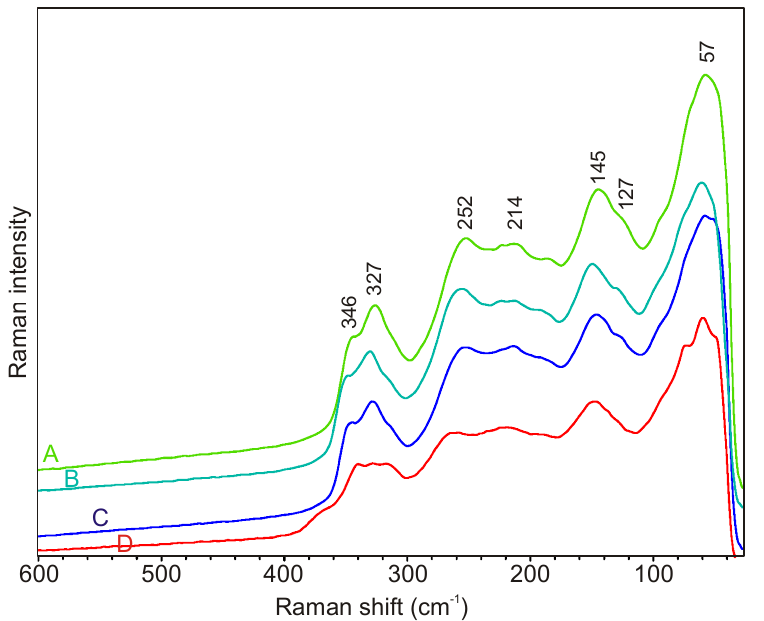
Figure 15. Comparison of Raman spectra of chovanite from Kľačianka (two samples A and B); Dúbrava deposit; Dimitrij vein (C); and Pollone mine, Italy (D).